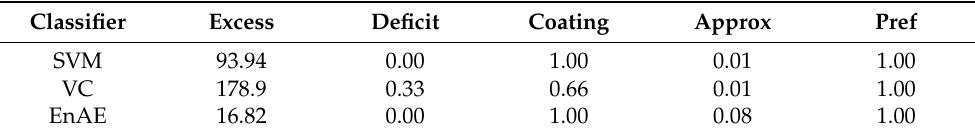
Table 6. SVM, VC and EnAE quality assessment by EDCAP.